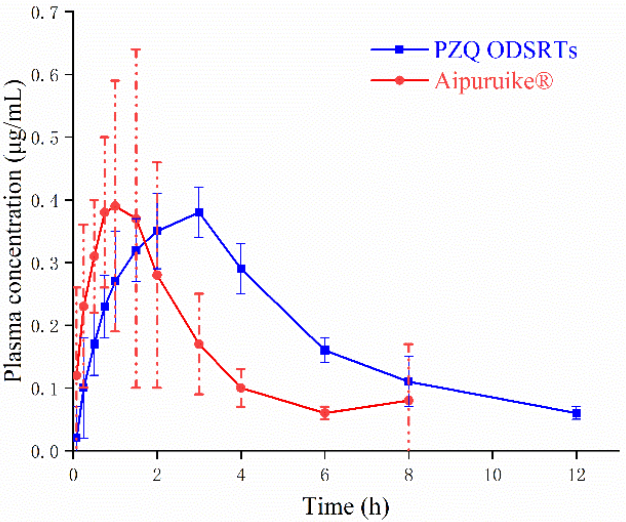
Figure 8. The relatively low LOQ for the method used in the determination of PZQ plasma concentrations was 50 ng/mL. The pharmacokinetic parameters are provided in Table 2.